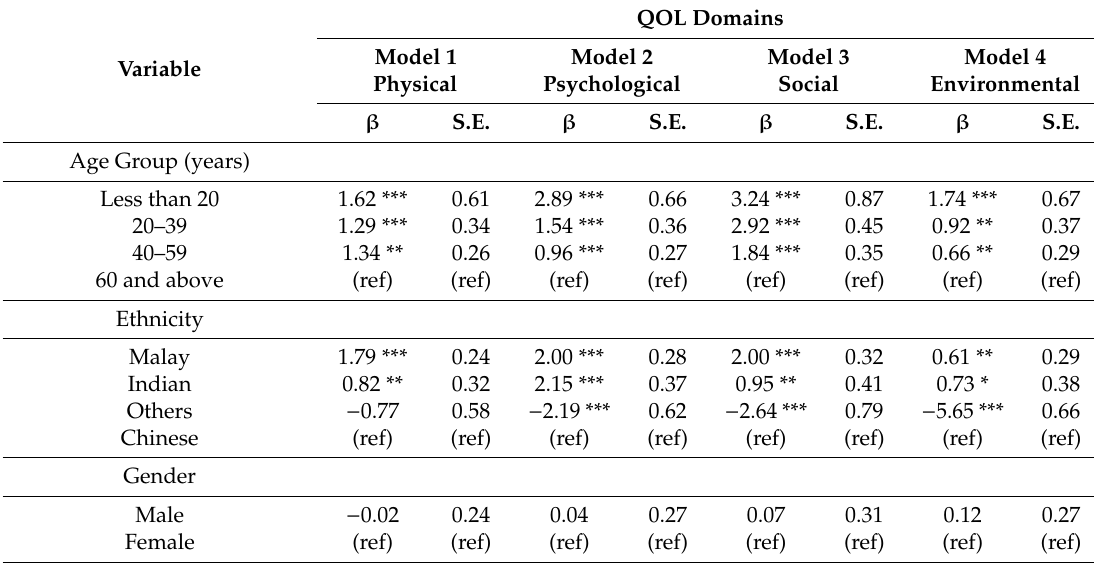
Table 3. Fitted estimates by means of generalized linear